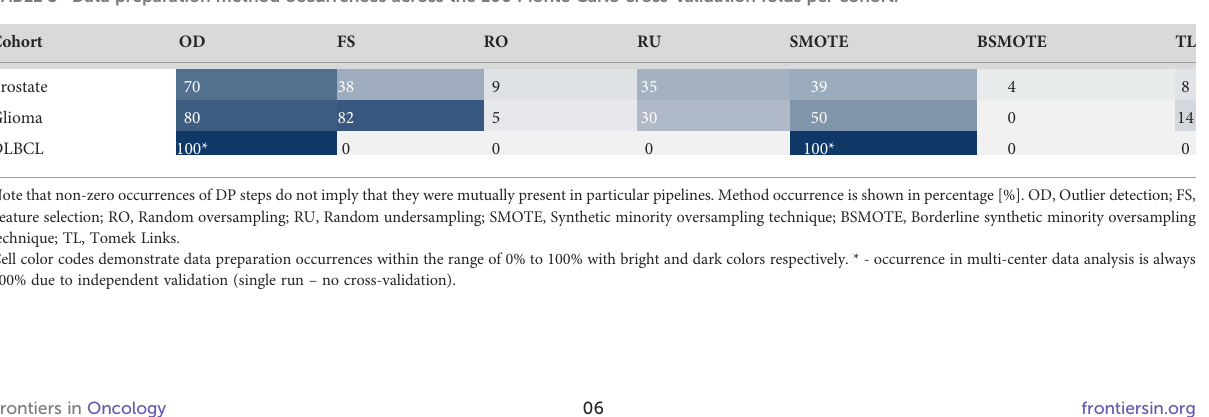
TABLE 3 Data preparation method occurrences across the 100 Monte Carlo cross-validation folds per